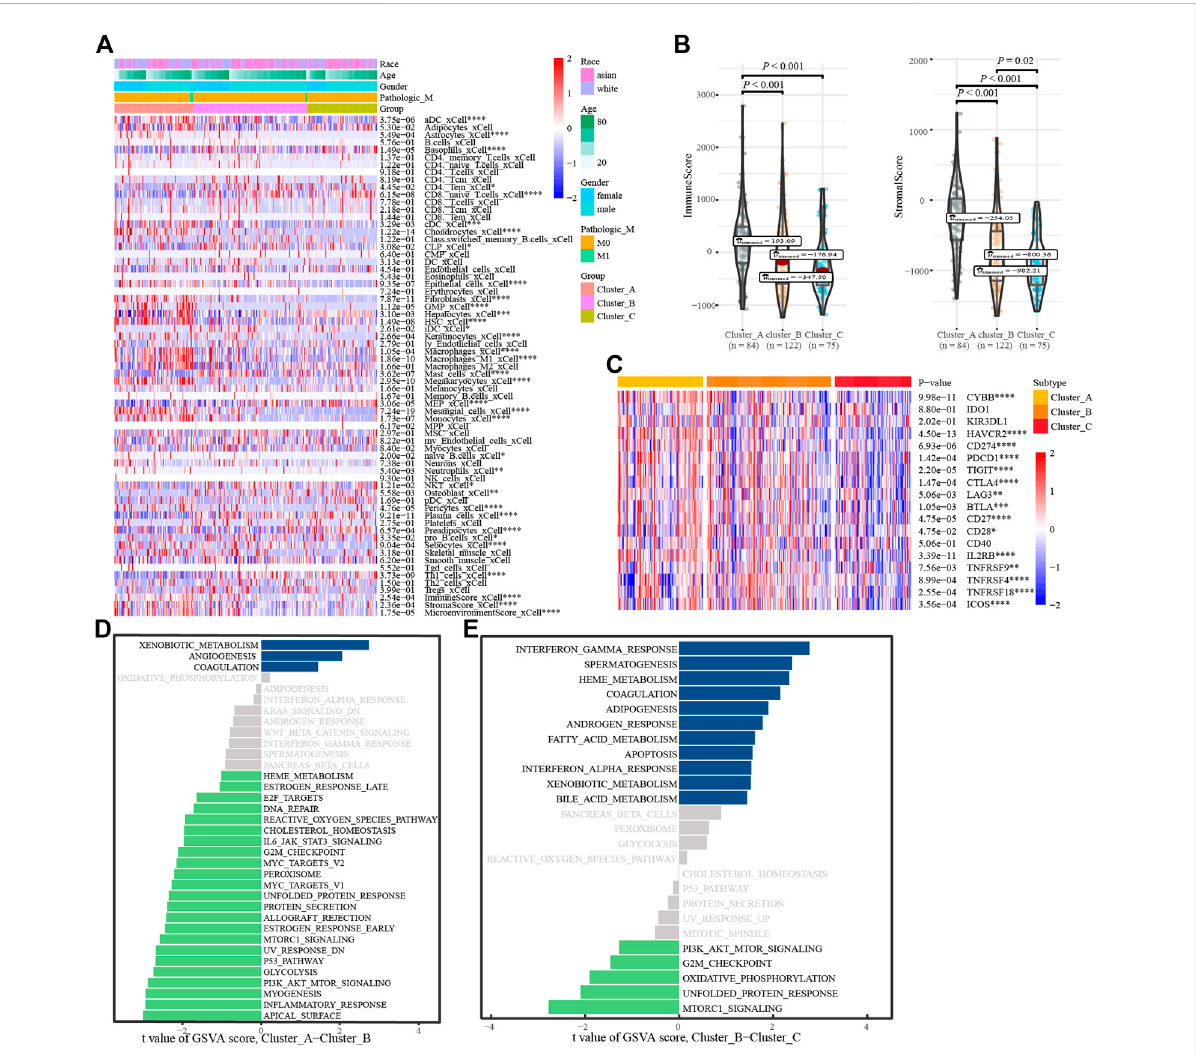
FIGURE 4 Annotationoftheglycosylationregulatorygenemodels. (A) .Enrichmentofimmunecellsandstromalcellsindifferentsubtypes; (B) .Differences inimmunescoresandstromalscoresindifferentsubtypes. (C) .Differentialexpressionanalysisofimmunecheckpointsindifferentsubtypes; (D) .The GSVA of Cluster_A-Cluster_B; (E) . The GSVA of